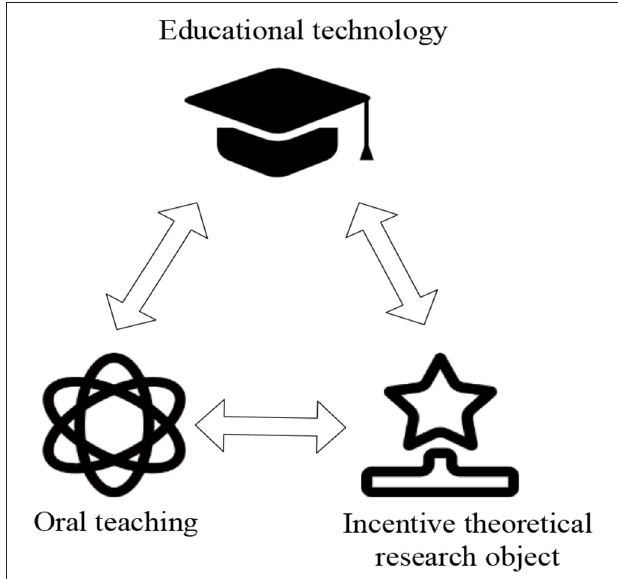
FIGURE 2 | Relationship between educational technology, motivation theory, and oral language